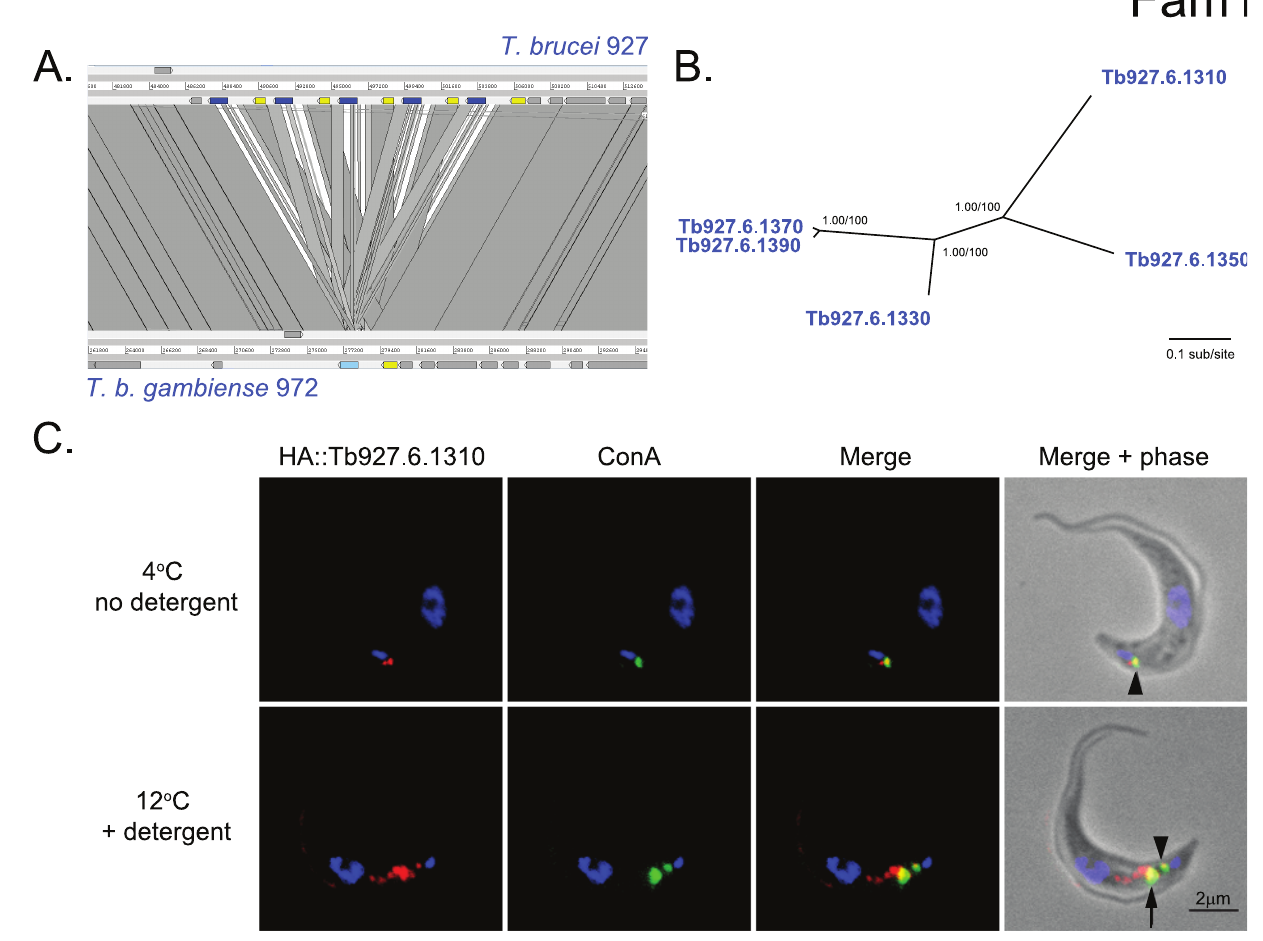
Figure 6. Phylogeny and expression of a T.brucei -specific, VSG-like hypothetical protein (Fam1). A . Fam1 consists of five, non-identical tandem gene copies at a strand-switch region on chromosome 5, which is unique to T. brucei . B . A Bayesian phylogram estimated from a multiple nucleotide sequence alignment of 1068 characters. The tree is midpoint-rooted. Nodes are supported by posterior probability values and non- parametric bootstraps generated from a maximum likelihood analysis using a GTR + G model. C . Immunofluorescence analysis of Tb927.6.1310 expression in T. brucei . Tb927.6.1310 was N-terminally HA epitope-tagged and expressed in bloodstream-form cells. Cells expressing HA::Tb927.6.1310 were loaded with FITC-concanavalin-A in serum-free media and incubated at either 4 u C (upper panel) or 12 u C (lower panel). ConA is restricted to the flagellar pocket at the lower temperature, whereas it is transported to, and trapped within, Rab5A positive early endosomes at 12 u C. Columns in each panel (from left to right); fluorescent stain of HA epitope tag (red); FITC-ConA fluorescence (green); merged images for fluorescence; merged images from phase and fluorescence. DAPI-stain of the nucleus and kinetoplast is shown in blue. HA::Tb927.6.1310 co-localizes with ConA at the flagellar pocket (indicated with arrow head) and early endosomes (indicated with a whole